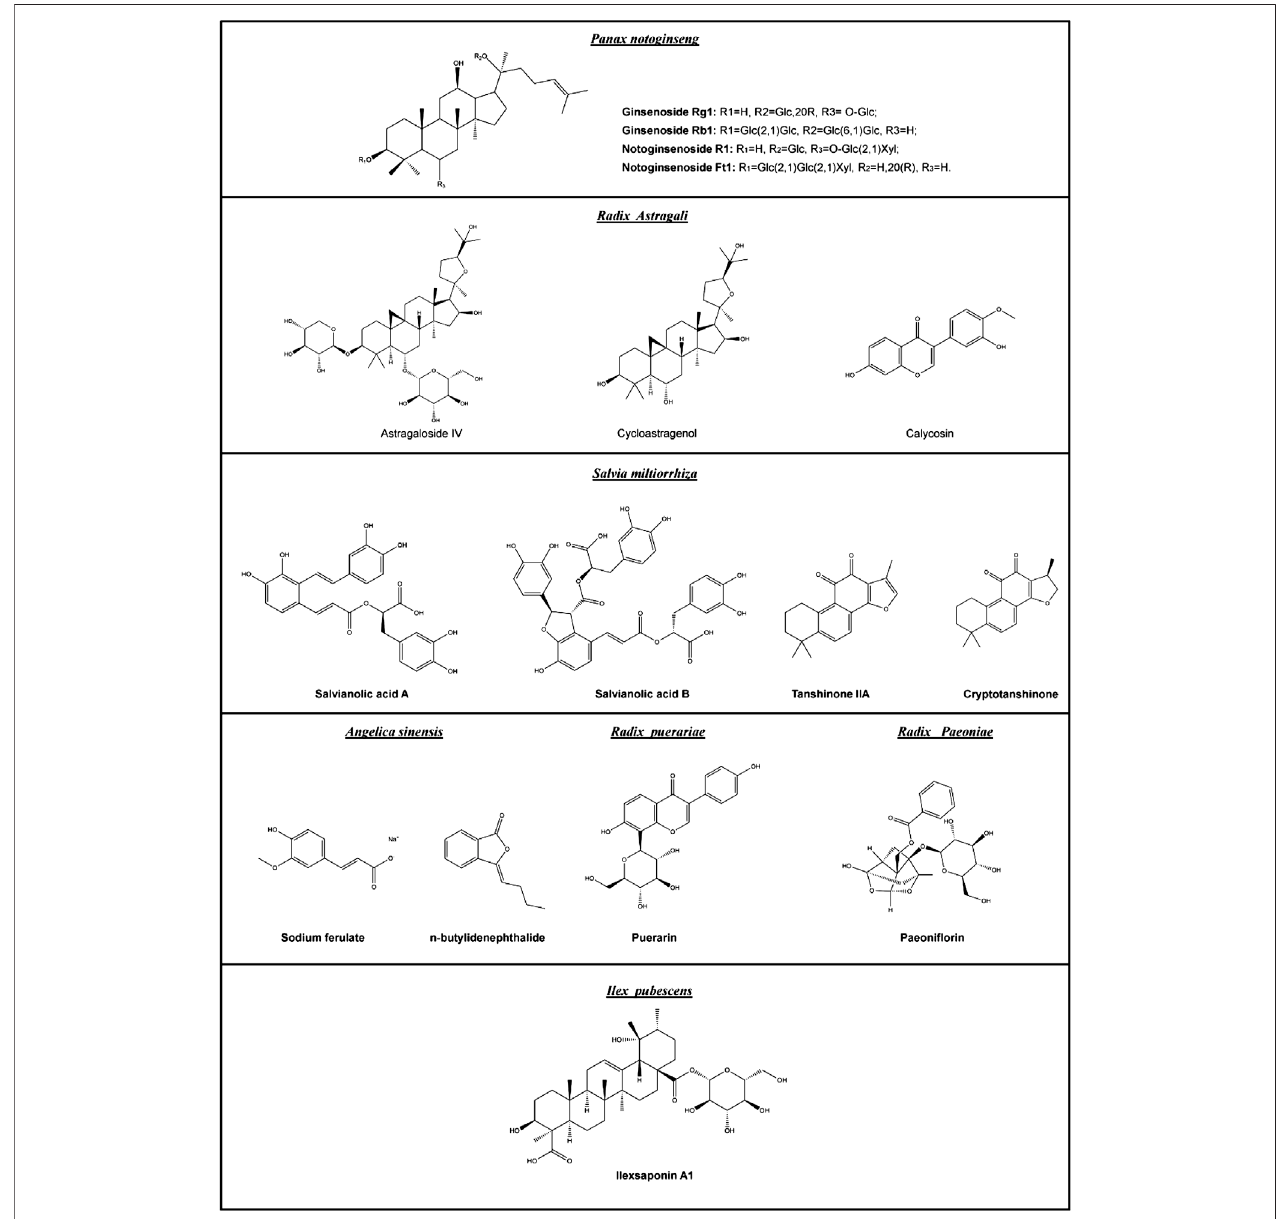
FIGURE 2 | Chemical structures of the major pro-angiogenic phytochemicals mentioned in this review.